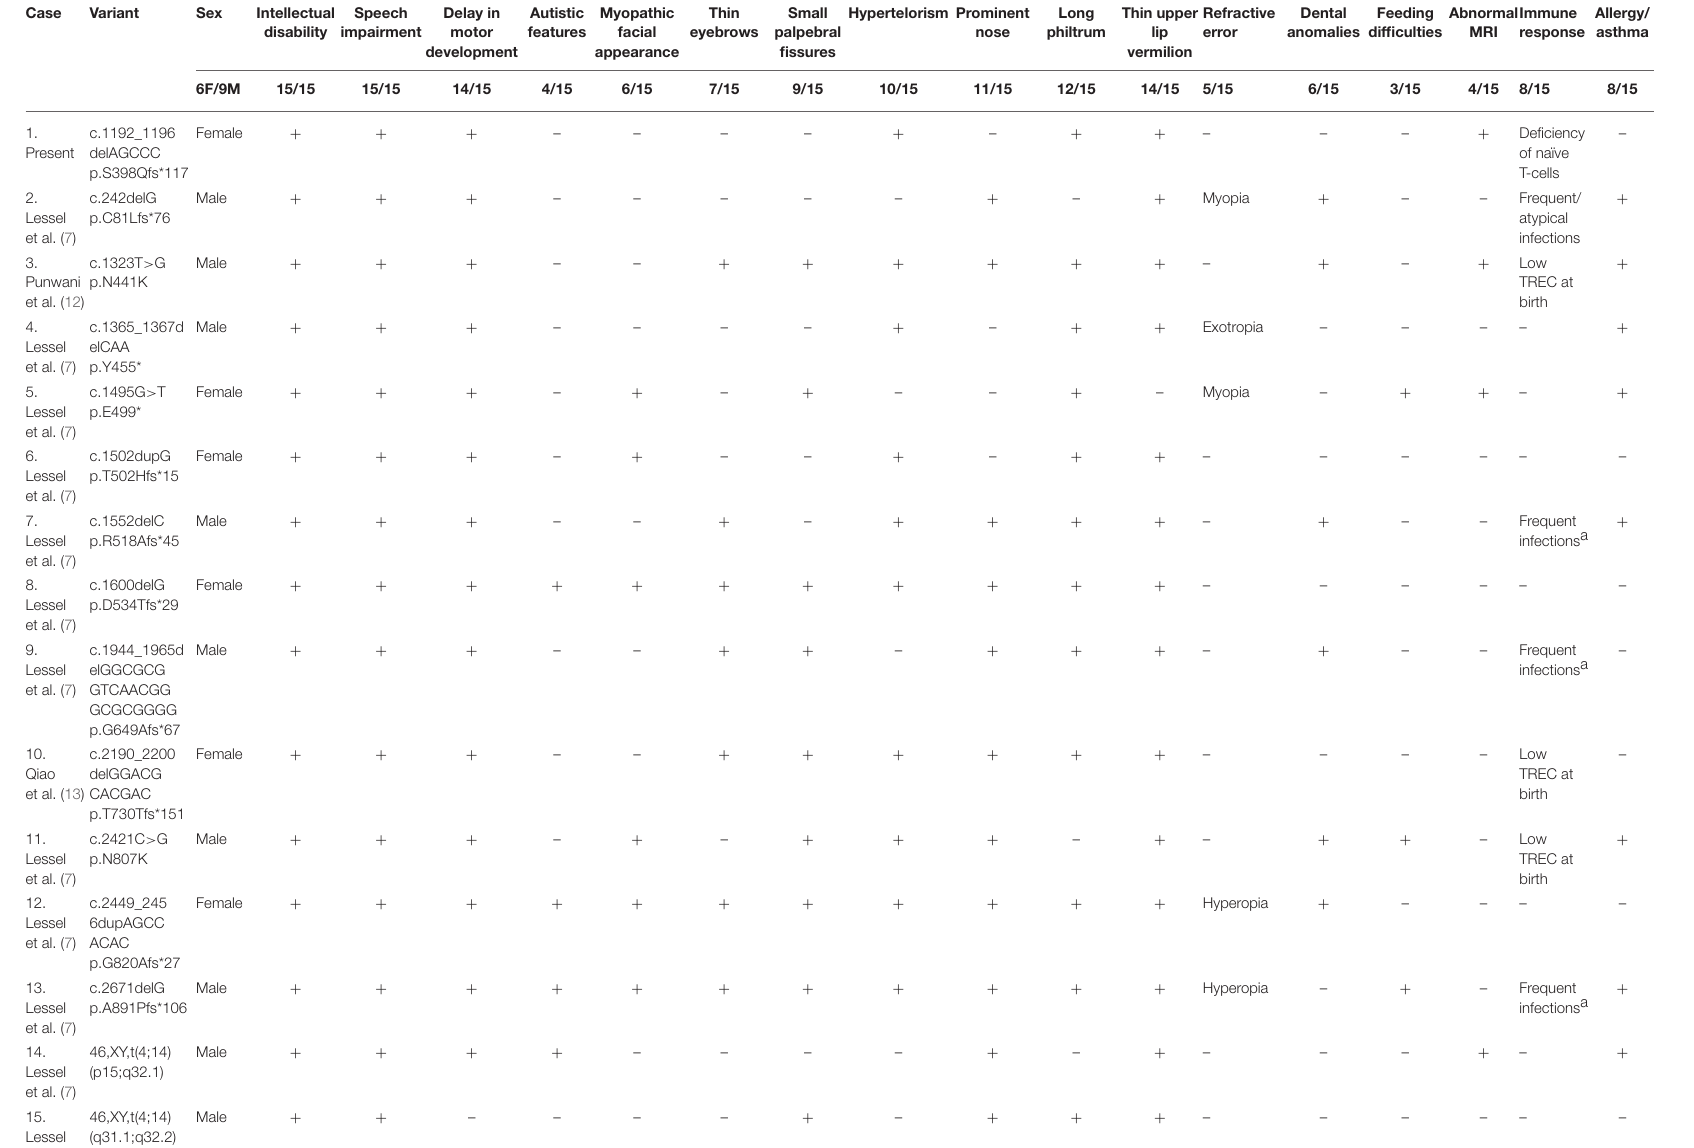
TABLE 2 | Variants and clinical manifestations of patients harboring BCL11B